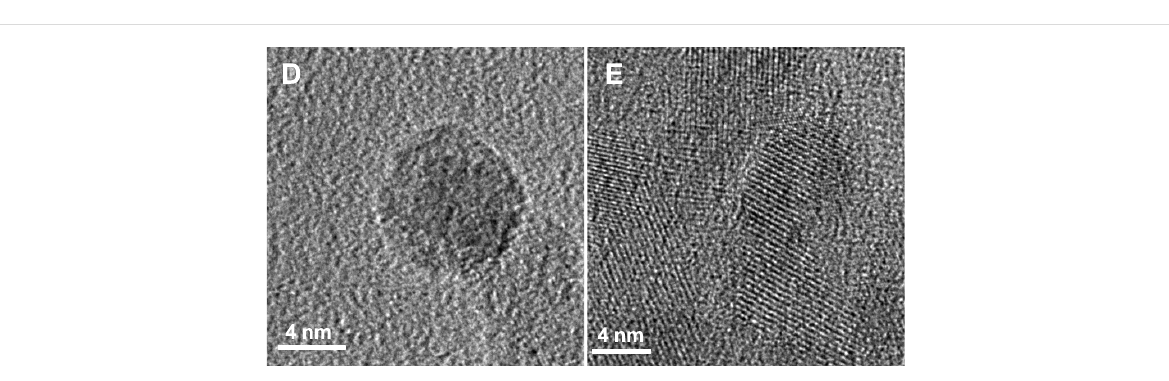
Figure 4: High resolution transmission electron microscope images of LiNbO 3 nanoparticles after template